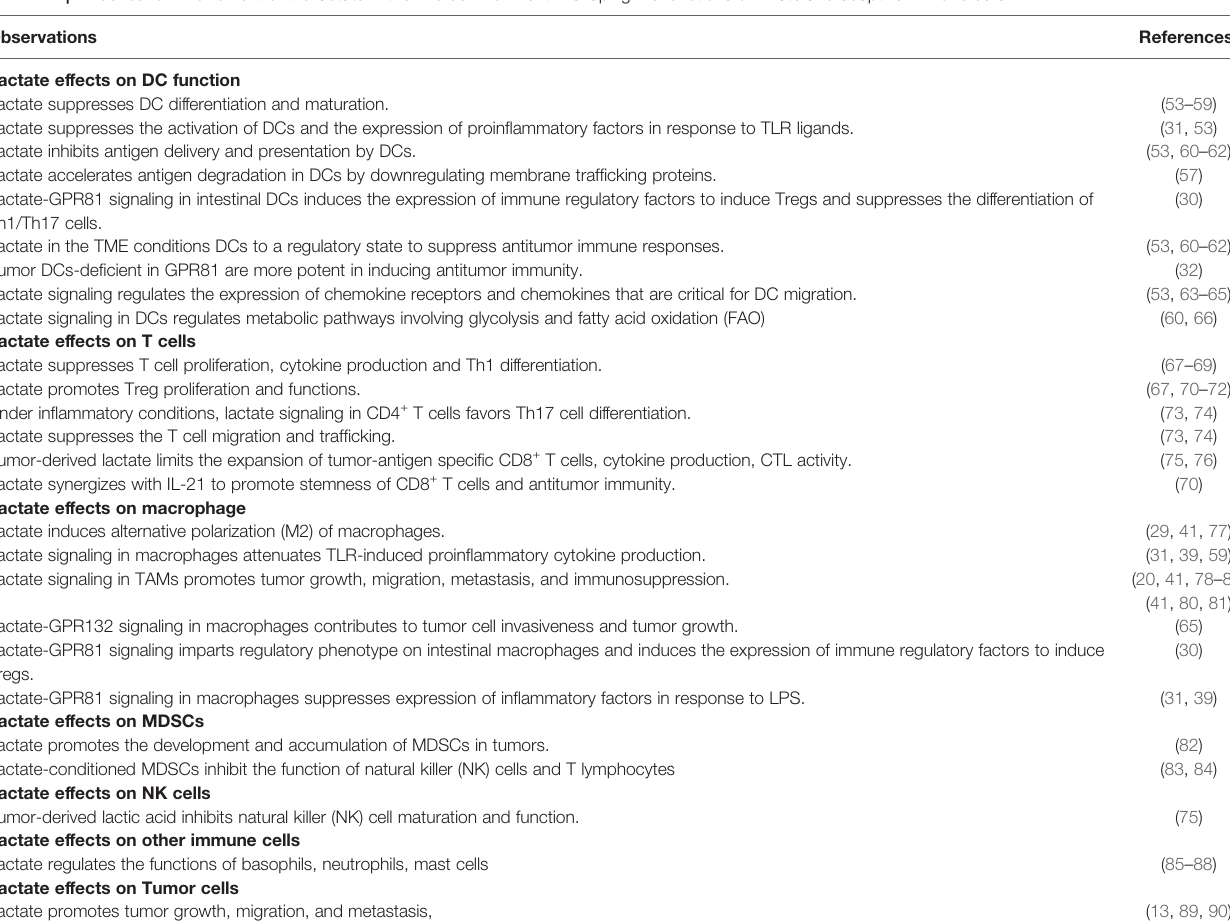
TABLE 1 | Evidence for involvement of the lactate in the microenvironment in shaping the functions of innate and adaptive immune